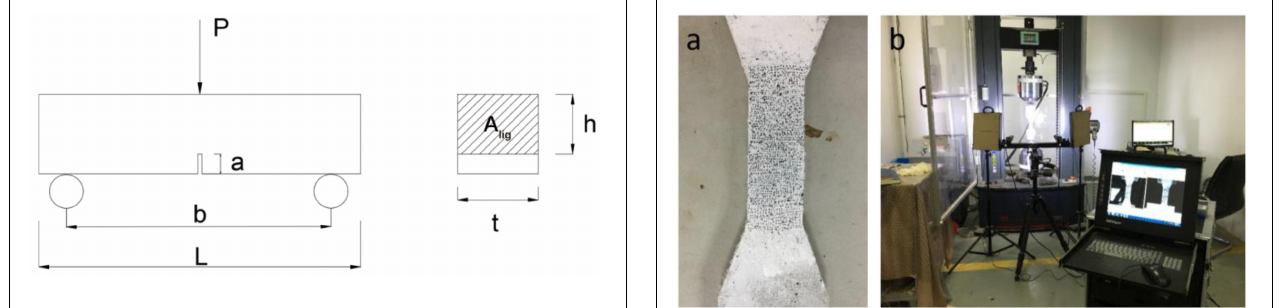
FIGURE 1 | Sketch map of the specimens used in the fracture energy measurement, where a = 10 mm, b = 100 mm, L = 1600 mm, and h = 30 mm.